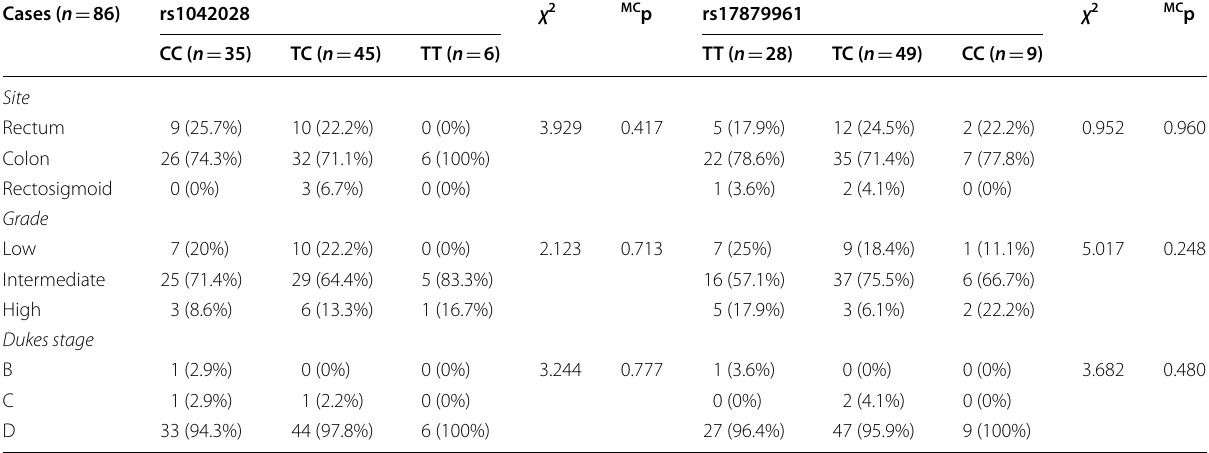
Table 7 Associations between rs17879961 and rs1042028 polymorphisms and clinicopathologic parameters of